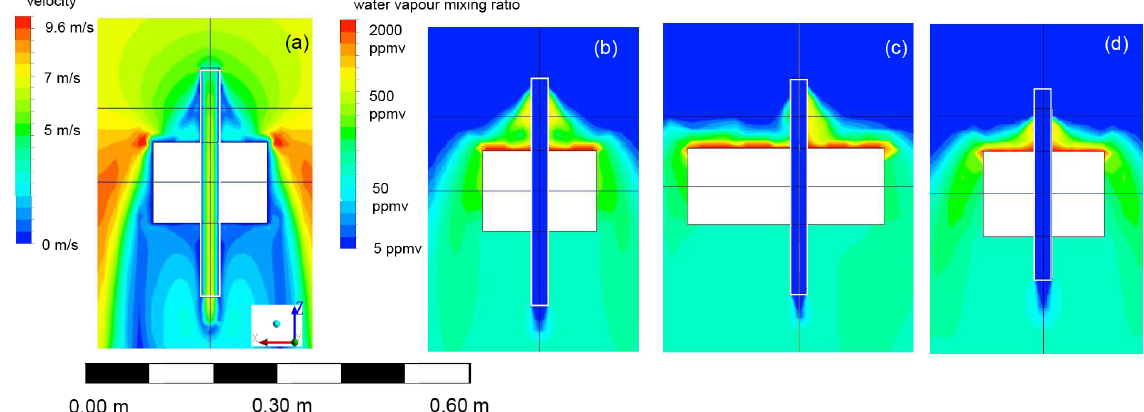
Figure 16. Contamination caused by an icy CFH box (Styrofoam) at 20hPa assuming a balloon ascent velocity of 7ms − 1 . (a) Flow velocity around the CFH housing; (b–c) H 2 O mixing ratio for two side views of the CFH; (d) H 2 O mixing ratio contour for an hypothetical CFH with intake tubes extending 6cm from the package instead of 11cm as for the CFH. Images used courtesy of ANSYS,